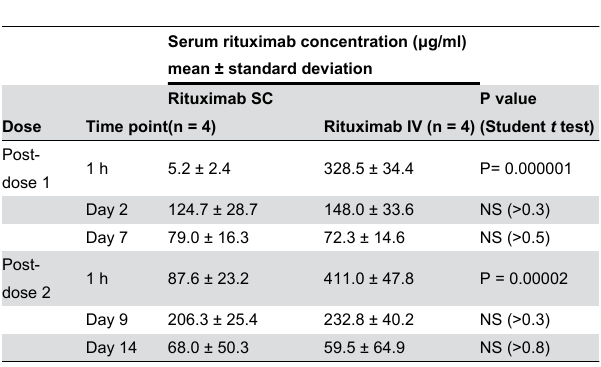
Table 1. PK analysis of serum rituximab levels after 2 × 10 mg/kg doses of SC (preformulated within rHuPH20) or standard IV